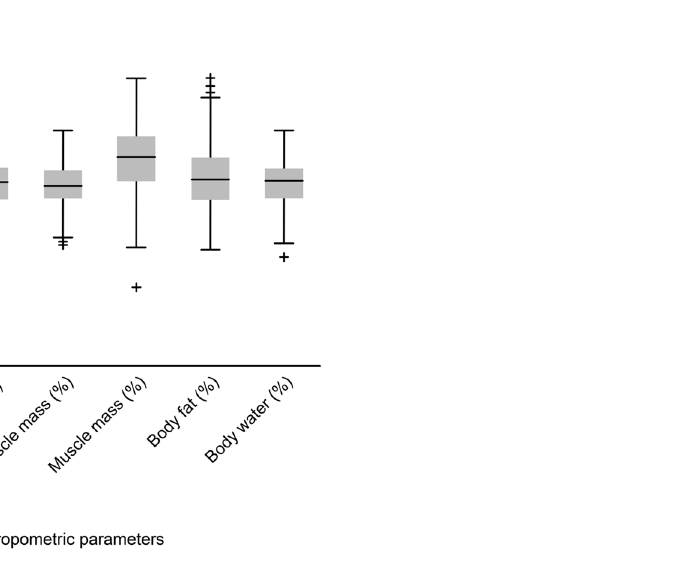
Figure 8. Box plot for estimation